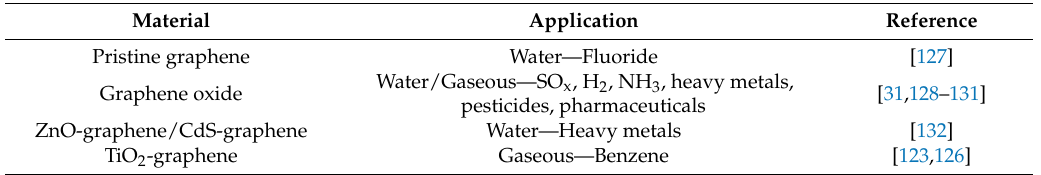
Table 3. Graphene materials and their use in environmental remediation